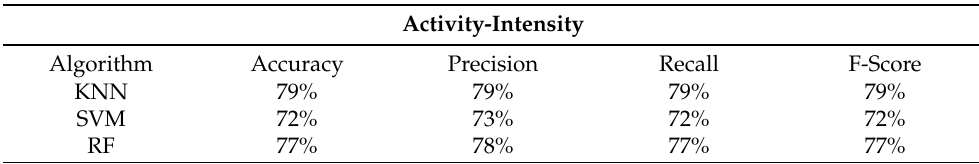
Table 1. Alternative 1—Classification with one classifier.